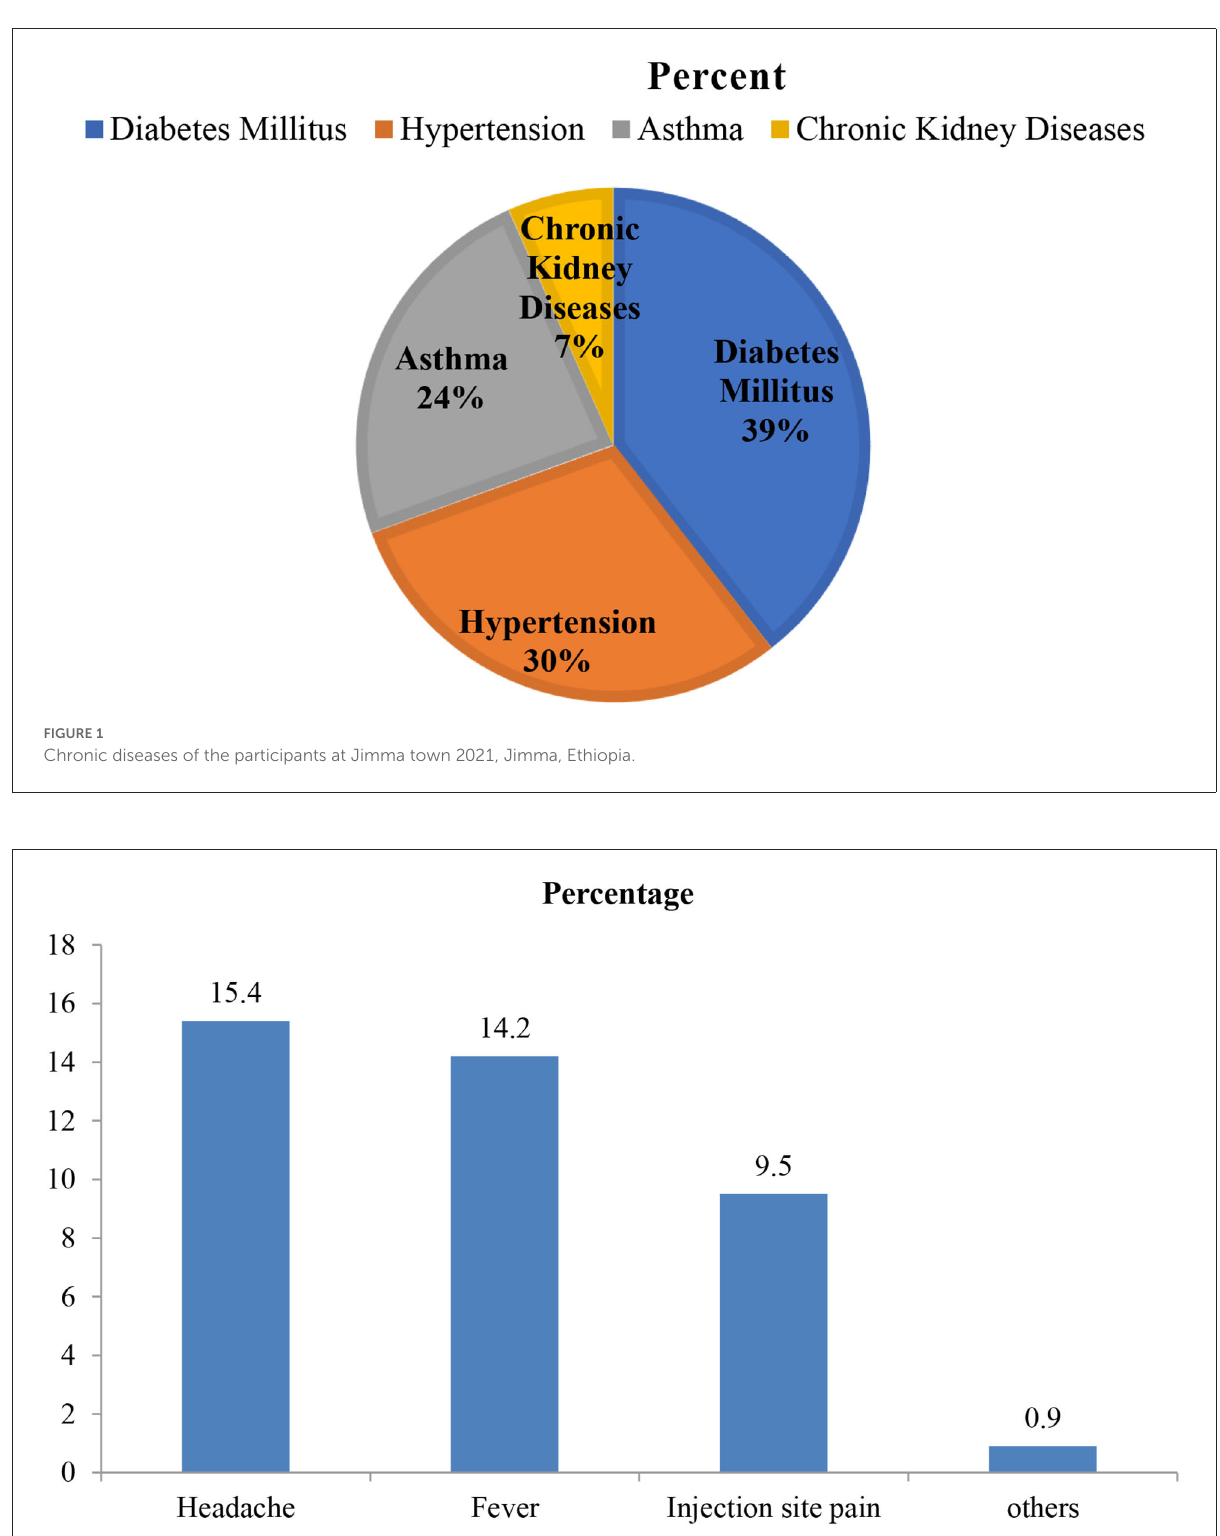
FIGURE2 Experienced side effects of vaccine the participants at Jimma town 2021, Jimma,